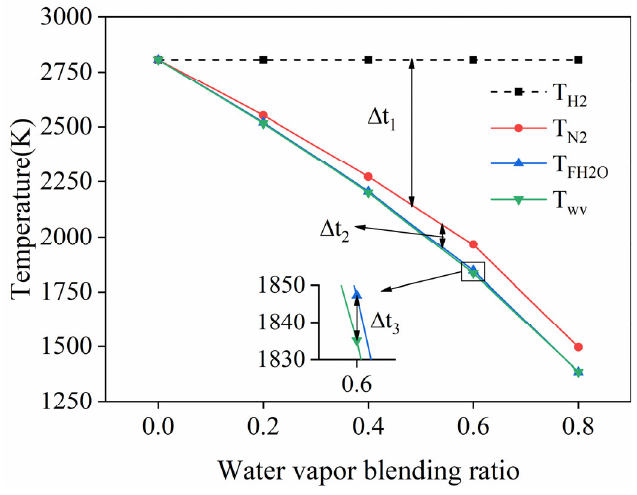
Figure 15. Effects of water vapor on combustion temperature.